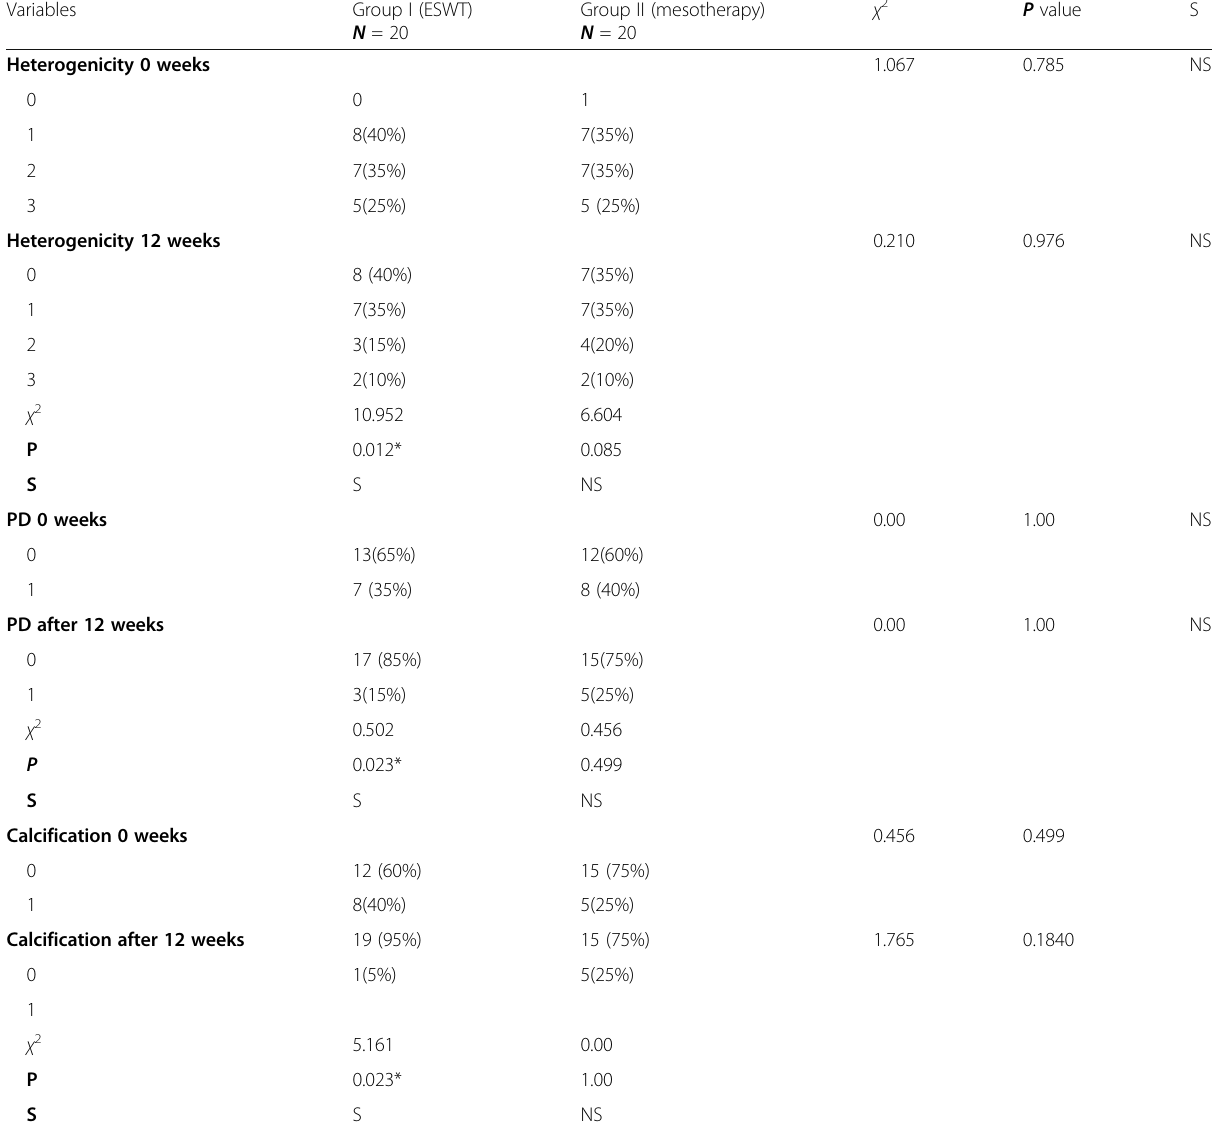
Table 5 Comparison between both groups as regards heterogenicity and PD at 0 week and 12 weeks